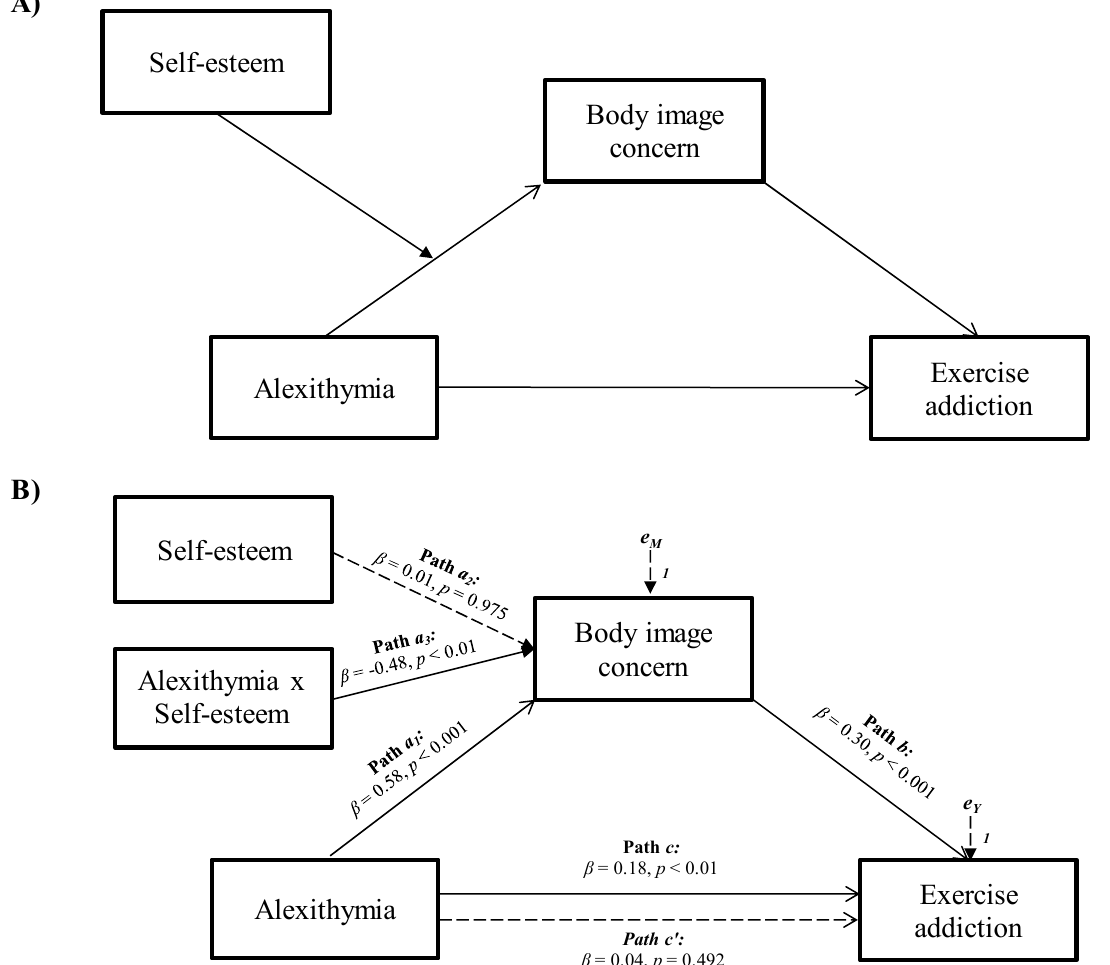
Figure 1. Statistical ( A ) and conceptual ( B ) forms of the moderated mediation model involving alexithymia, body image concerns, self-esteem, and exercise addiction.